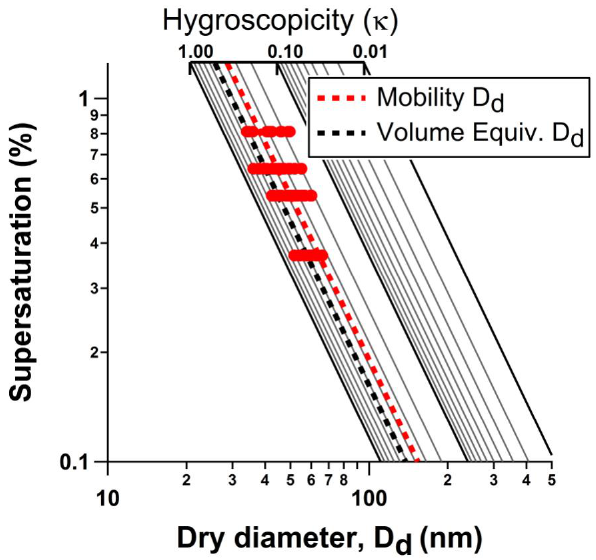
Figure 7: Supersaturation vs. the dry activation diameter for one experiment of freshly emitted chamise biomass burning aerosol. Markers indicate the data from the SMPS-CCNC and the red line is the best-fit κ between the points. The black line indicates the κ when the volume equivalent diameter is used instead of the mobility diameter.